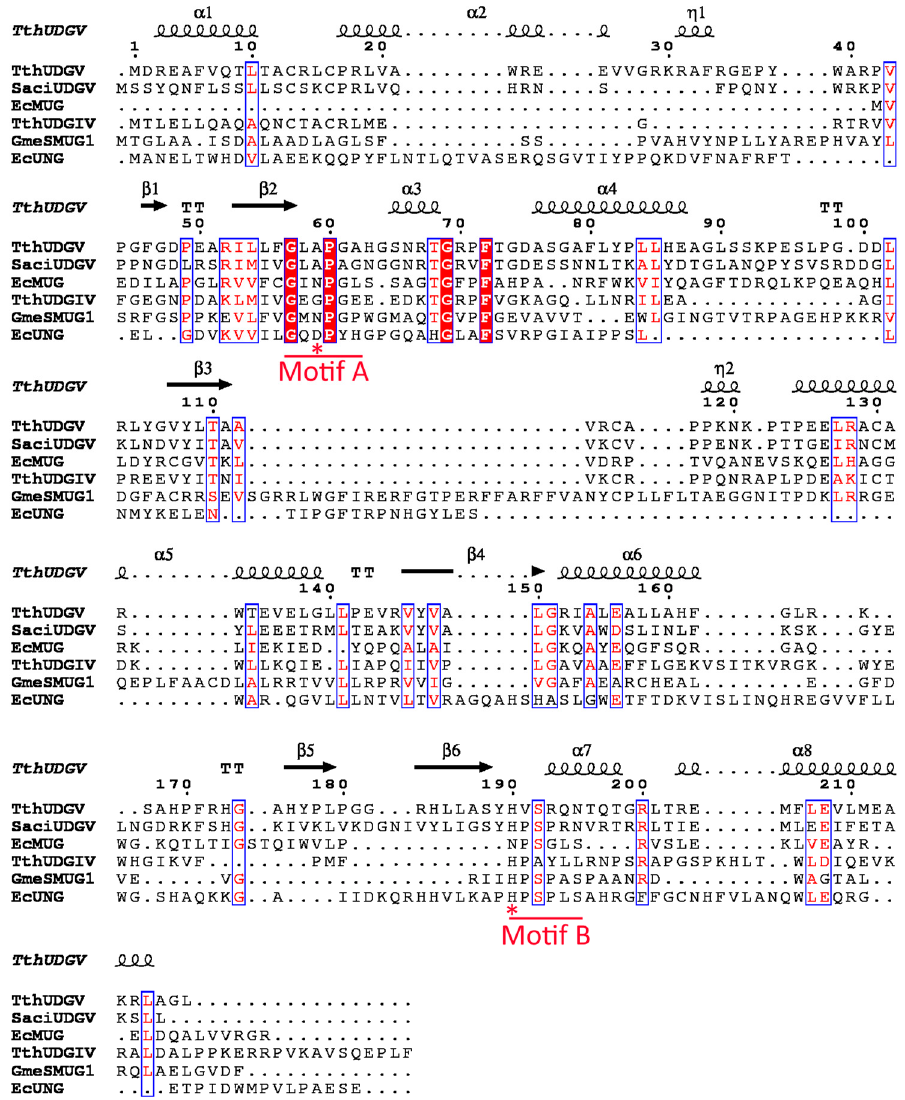
Figure 2. Structure-based sequence alignment of the UDG superfamily. Completely conserved residues among family 1–5 UDGs are boxed with solid lines. The location of the secondary structure elements of TthUDGV is represented at the top of sequences. The conserved motifs A and B are underlined by red lines, and the active residues are marked by red stars. Abbreviations: EcUNG, E. coli UNG; EcMUG, E. coli MUG; GmeSMUG, Geobacter metallireducens SMUG; TthUDGIV, T. thermophilus UDGIV;